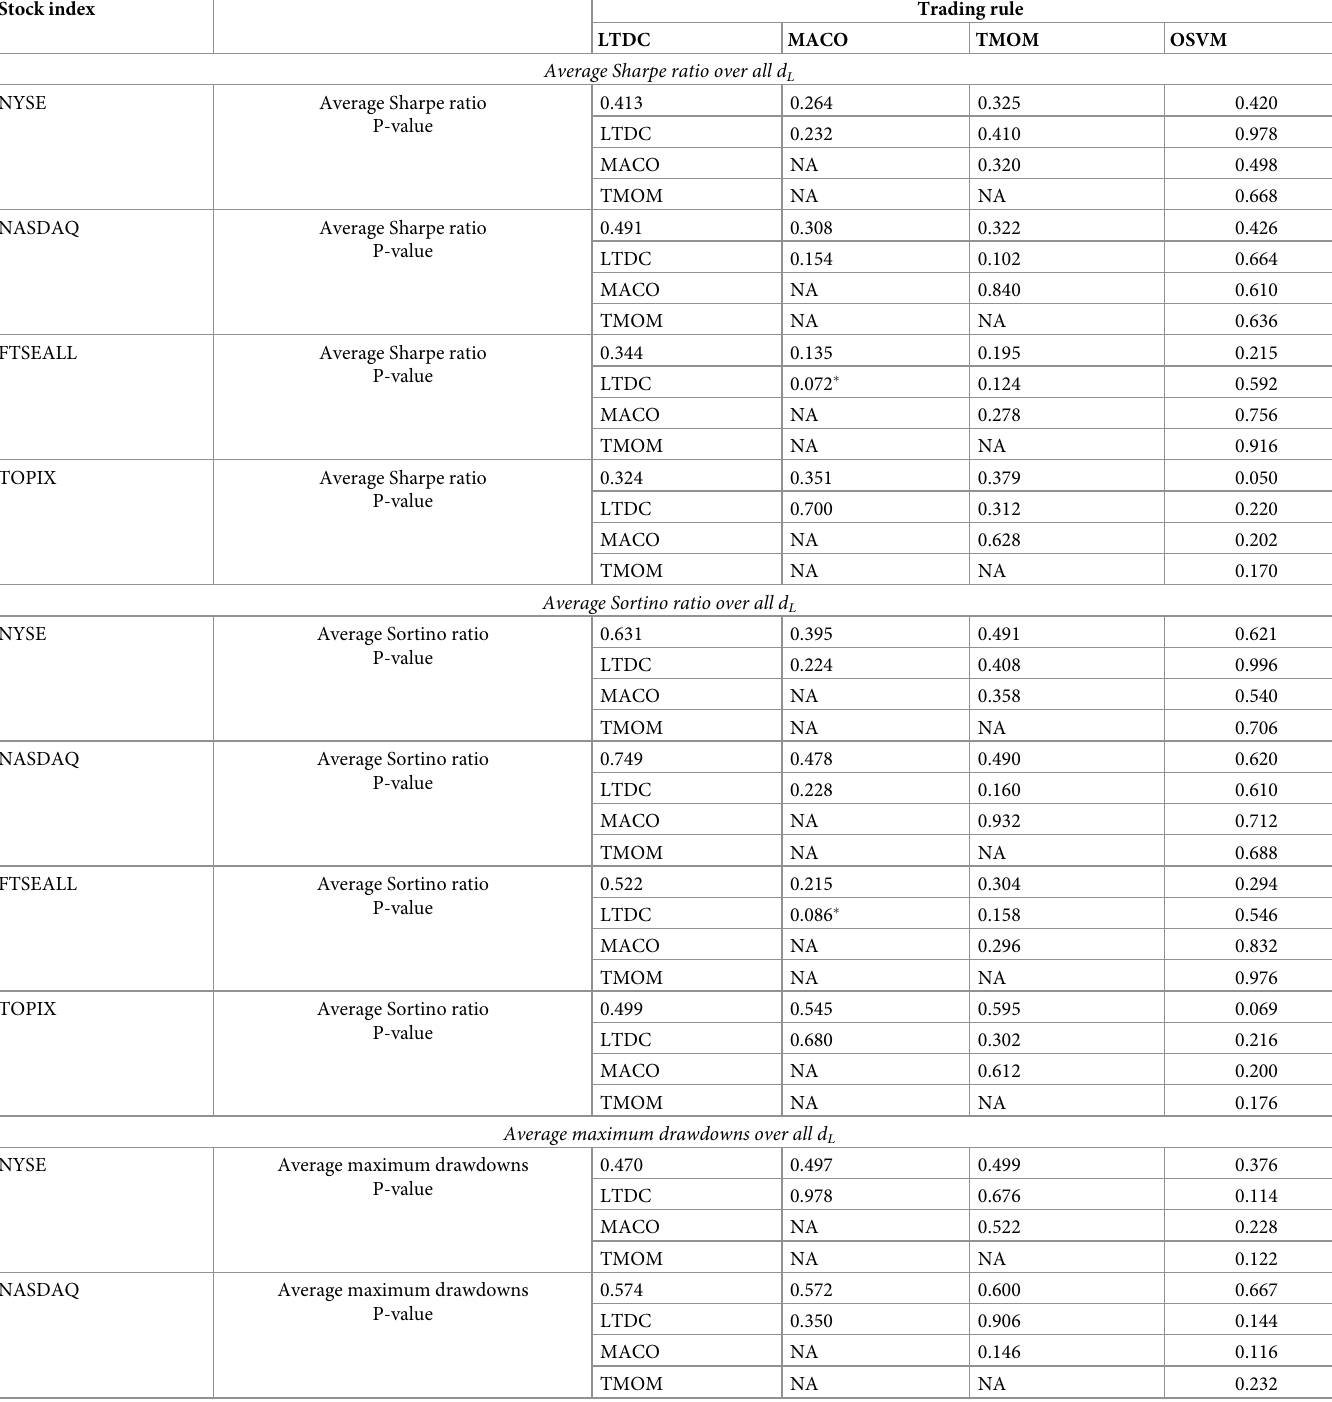
Table 3. Average risk tolerance statistics and the tests of equality comparison between two